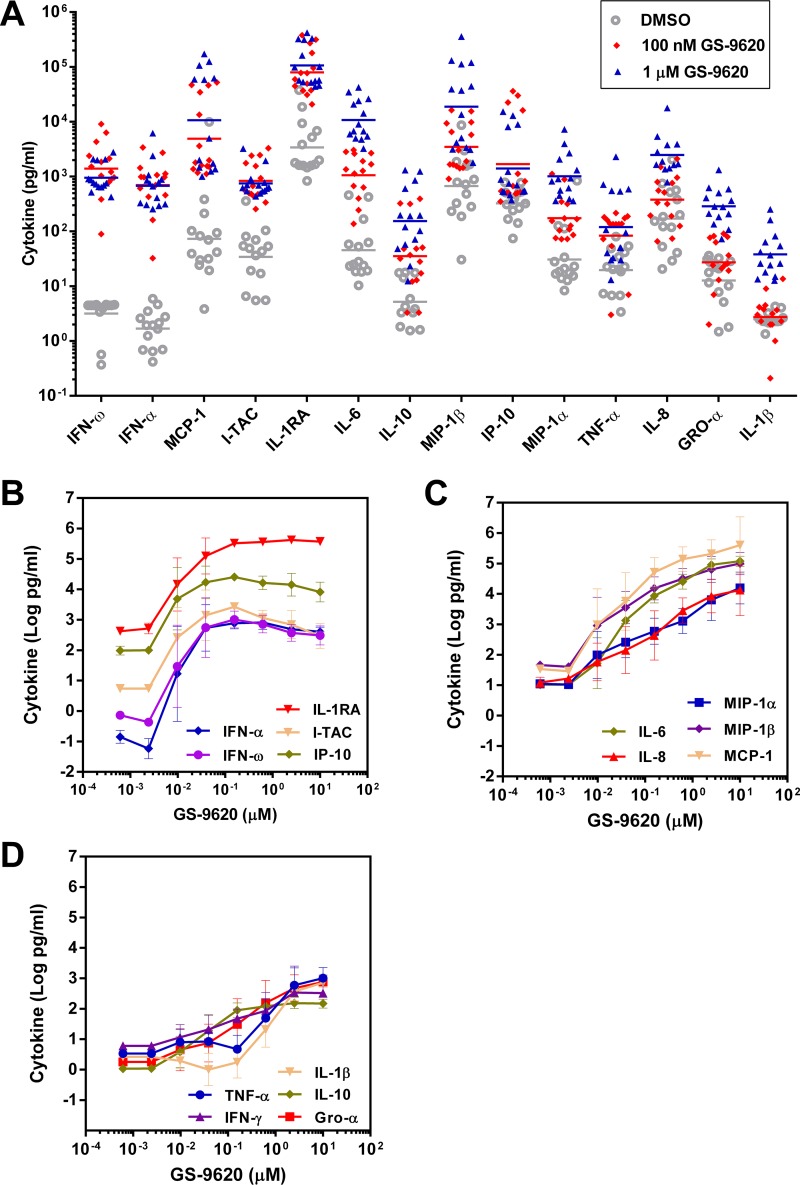
GS-9620 induces type I IFNs. Cytokine levels observed in cell culture supernatants after treatment of PBMCs isolated from HIV-infected individuals with the indicated concentrations of GS-9620. (A) Results from individual donor PBMC samples (n = 14) for select GS-9620 concentrations. The lines represent the geometric means. (B to D) GS-9620 dose responses for induced cytokines (n = 4). The data represent means of three replicates ± standard deviations.